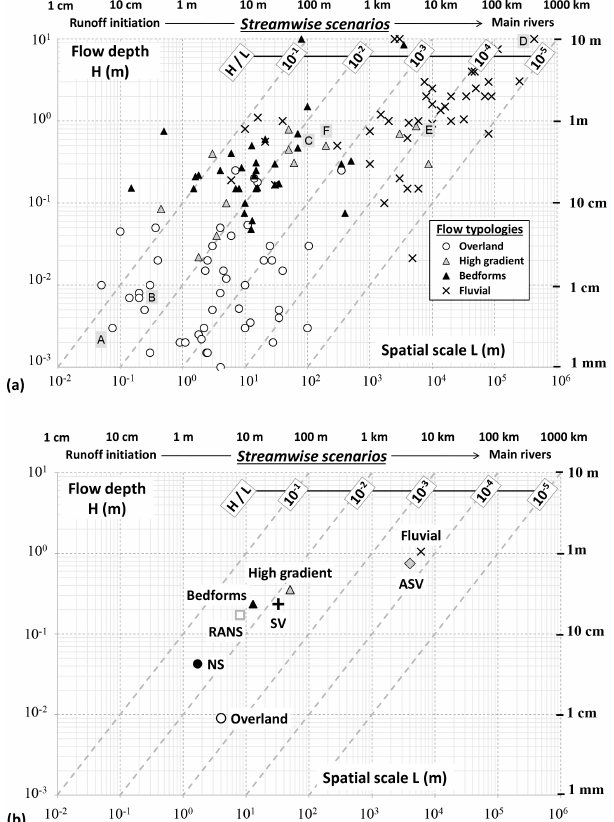
Figure 6. Position of the flow typologies in the ( L , T ) plane for the A to F, Table 1) for illustration (a) . Median positions for the choice of free-surface flow models (Navier–Stokes: NS; Reynolds- averaged Navier–Stokes: RANS; Saint-Venant: SV; or approxima- tions to Saint-Venant: ASV) and the study of flow typologies (Over- land, High-gradient, Bedforms or Fluvial) across scales in the ( L , T ) plane (b) . A transverse analysis involves forming L/T ratios, searching for clues to model selection according to these “system evolution velocities” or governed by flow typologies that would ex-